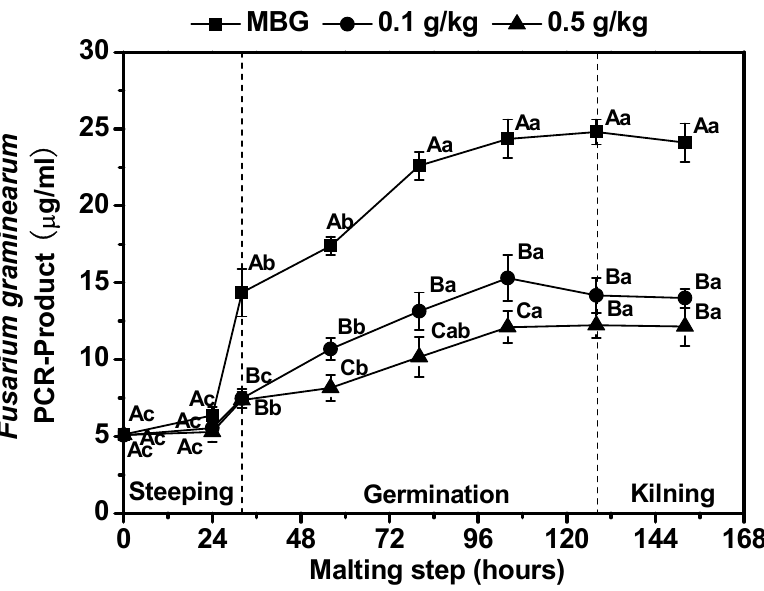
Figure 2. Effects of chitosan on Fusarium graminearum biomass in barley during malting. Each number represents the mean ± standard deviation of three replicates. Within the same malting time and among different treatment conditions, different capital letter superscripts indicate significant differences ( p < 0.05); within the same treatment condition and among different malting times, different lowercase superscripts indicate significant differences ( p <